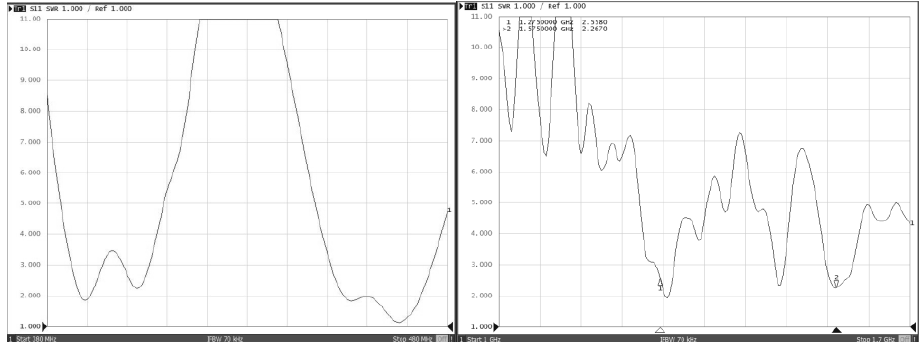
Fig. 5. Experimental SWR for Argos-3 band (а) и GPS band